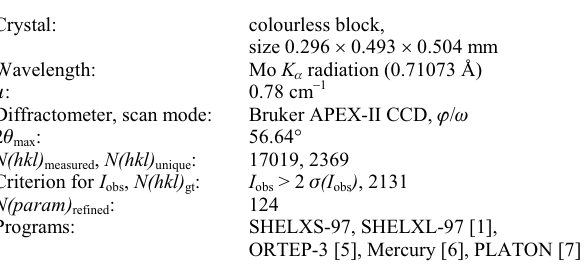
Table 1. Data collection and